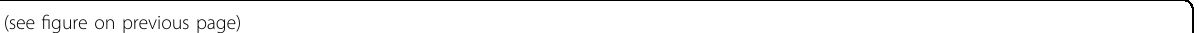
Fig. 7 The high expression of CXCR4, β -catenin, and PPAR δ is positively correlated and predicts poor prognosis in human lung ADC. a , c CXCR4, β -catenin, and PPAR δ protein levels were evaluated in 75 human lung ADC tissues using immunohistochemical staining of tissue microarrays; scale bar: 100 μ m. Case 1 and Case 2 represent two different patients. For each case, tumour and corresponding tissues were from one patient. b Kaplan – Meier analysis was used to evaluate patients ’ overall survival with lung ADC and high or low expression of CXCR4, β -catenin, and PPAR δ . d Analysis of the clinicopathological signi fi cance of CXCR4, β -catenin, and PPAR δ protein in 75 human lung ADC tissues. e , f Pearson correlation analysis was performed to detect correlations between the expression of CXCR4, β -catenin, and PPAR δ